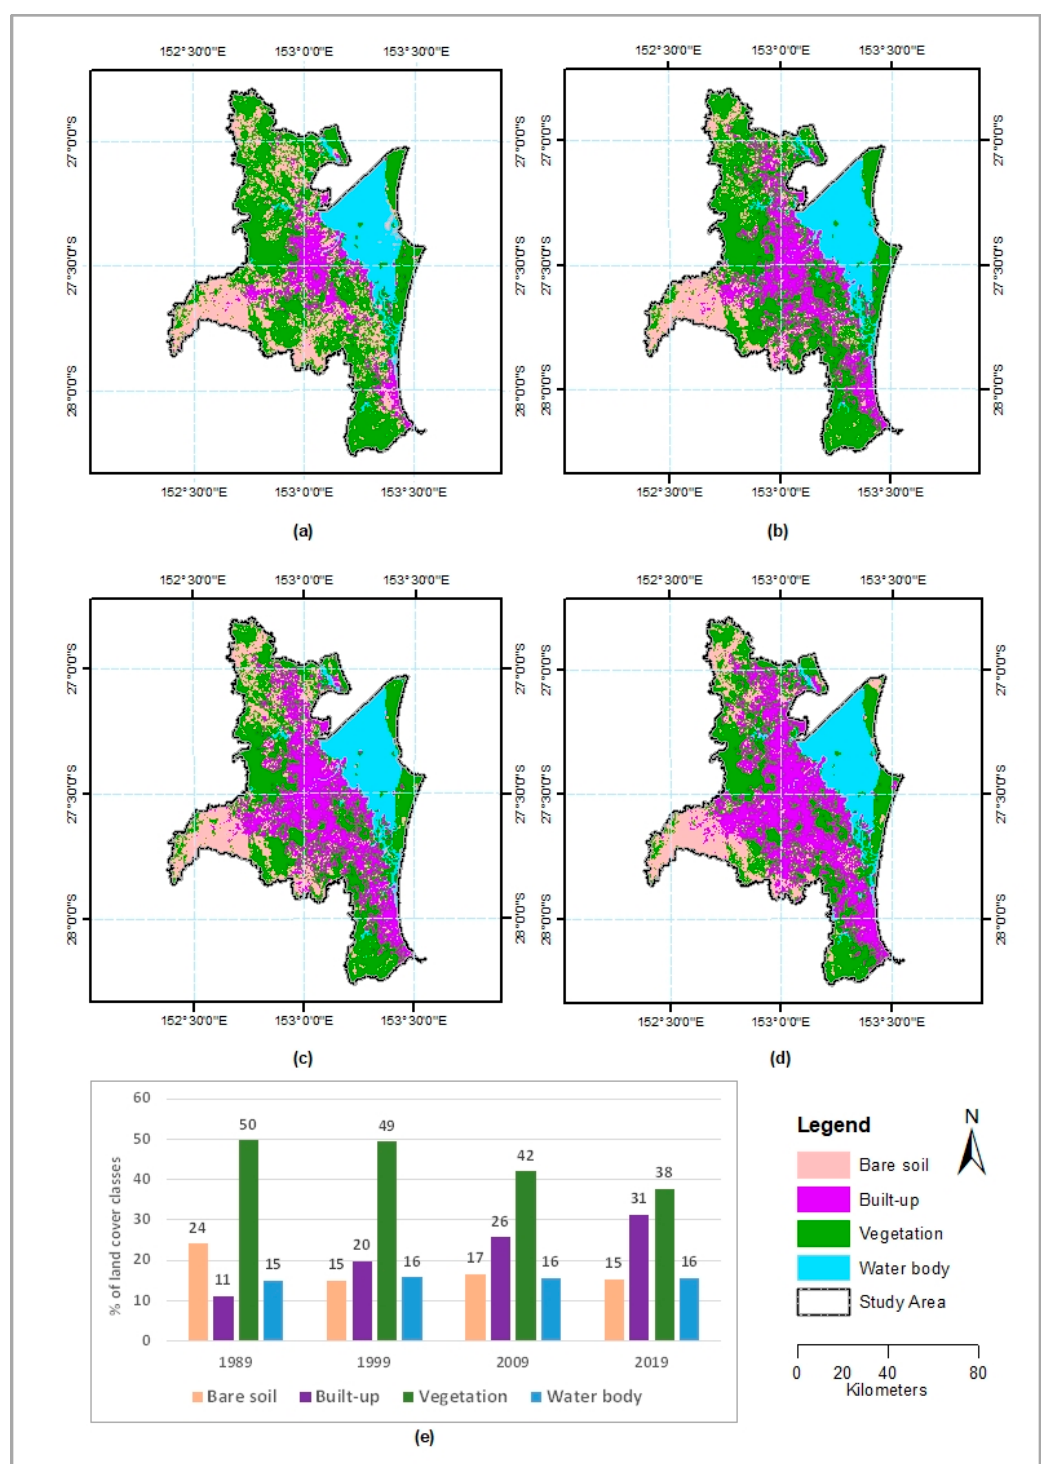
Figure 3. ( a ) Classified image of 1989; ( b ) Classified image of 1999; ( c ) Classified image of 2009; ( d ) Classified image of 2019; ( e ) % of changes in LULC between 1989, 1999, 2009 and 2019.